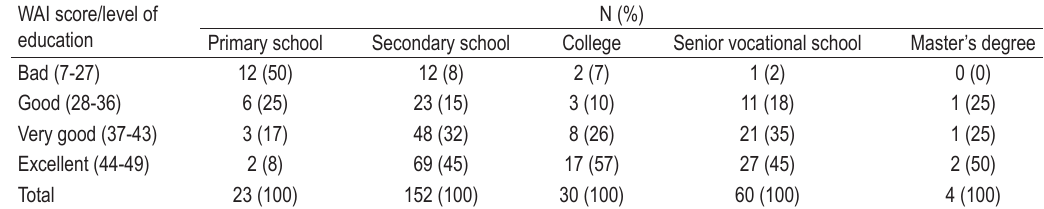
TABLE 4. Subjectively perceived work ability according to the level of education WAI score/level of